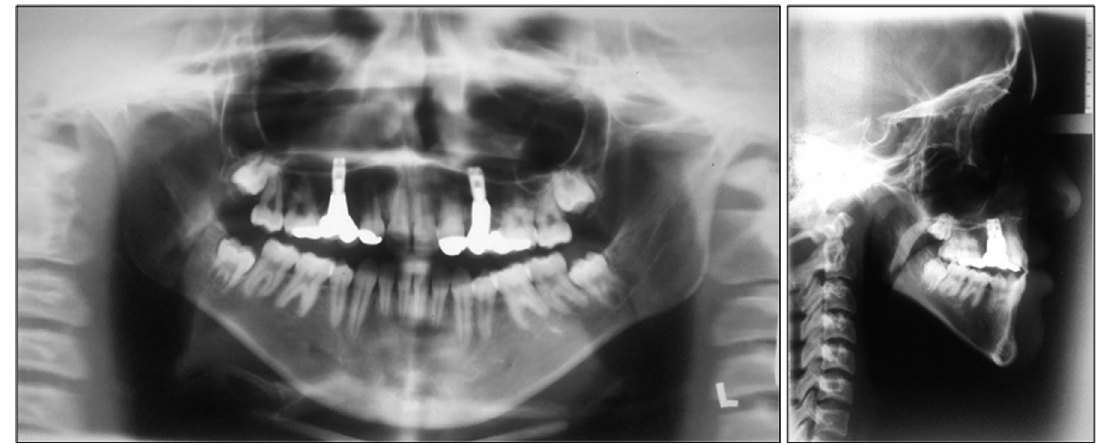
Figure 6. Post-Facemask lateral cephologram and orthopantomogram